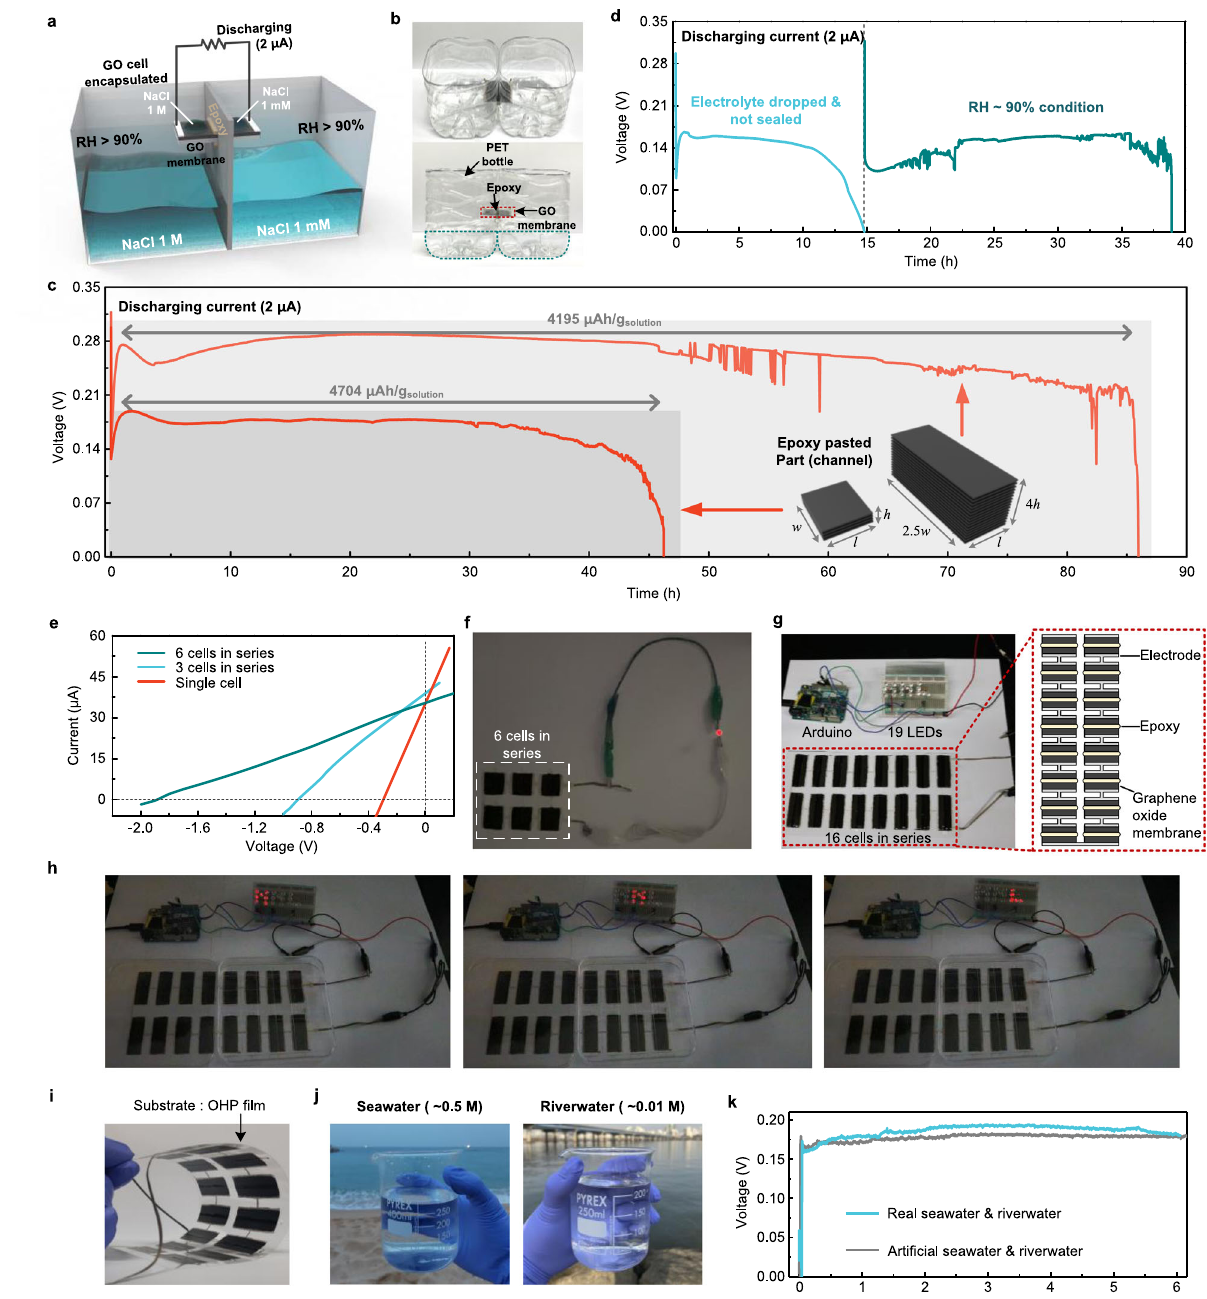
Fig. 5 Applications of the neuromorphic cell. a Experimental setup for discharging test. b Photograph of experimental setup. c Discharge curve of Cell I ( w = 1.5 cm, l = 3 mm, and h = 5 μ m) and Cell II ( w = 4 cm, l = 3 mm, and h = 20 μ m) at sealed state. l , w , and h are the length, width, and height of the epoxy-pasted part (channel), respectively. d Discharge curve of a cell I ( w = 1.5 cm, l = 3 mm, and h = 5 μ m). When the cells is not sealed (RH ~50%), the NaCl solution dries, and the discharge terminates in ~15 h (blue curve). However, when the cell is sealed in that state, it can be discharged again (green curve). e I – V curve of series-connected cells ( w = 1.5 cm, l = 3 mm, and h = 20 μ m) under a concentration gradient of 1000. f Switching on a red LED using six series-connected cells. g Photograph of 19 red LEDs is connected to a programmed Arduino (left). Schematic of the 16 cells in series (right). h Switching on 19 red LEDs using 16 cells in series. i 16 cells that are drop-casted onto fl exible plastic substrates (OHP fi lm). j Real seawater and river water for application to the cell. k Open-circuit voltage for 6 h using concentration gradient between seawater and river